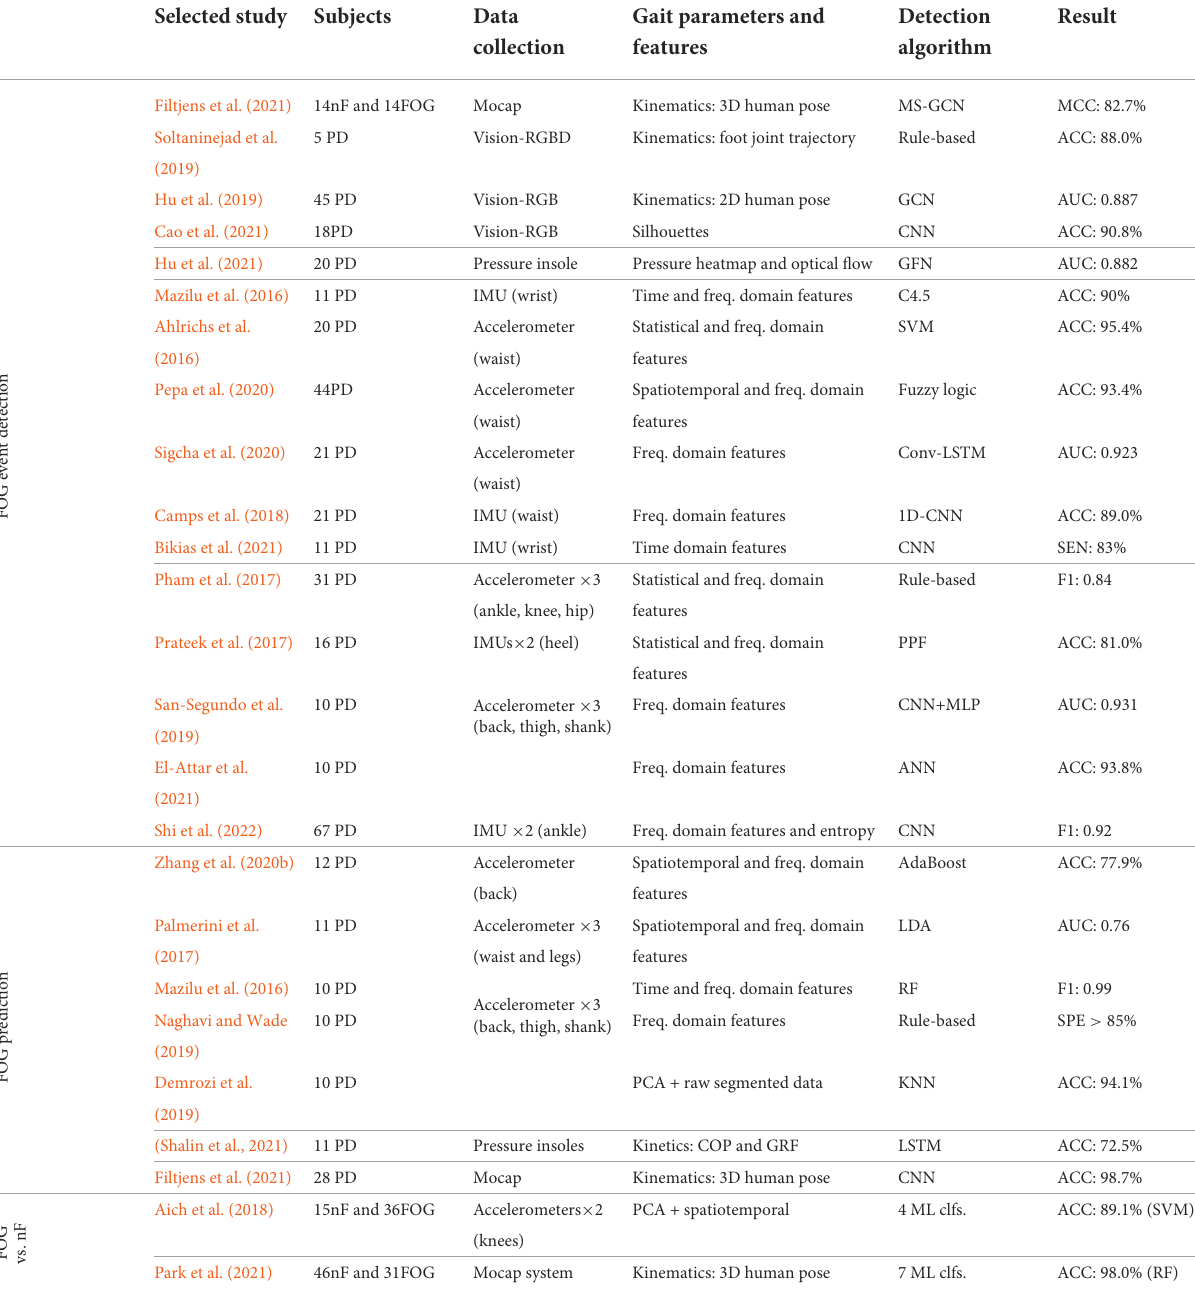
TABLE 5 Summary of recent studies on detection of FOG event, prediction of FOG event, and discrimination of PD with/without FOG. Selected